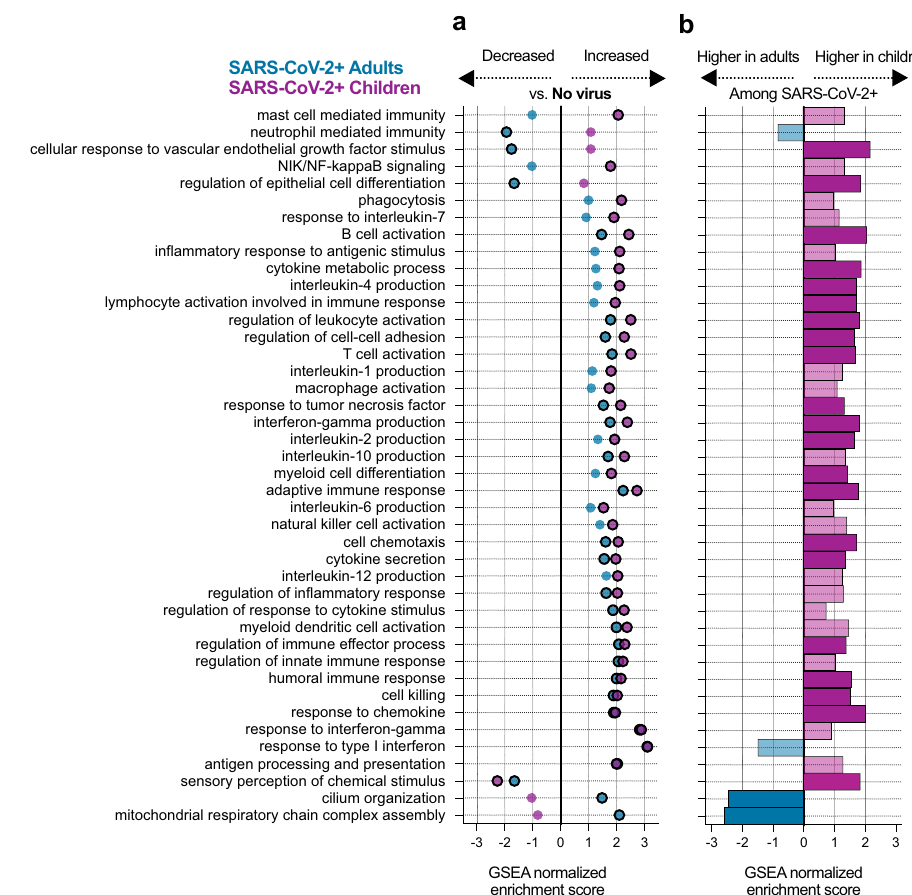
Fig. 2 Pathways activated in children and adults upon SARS-CoV-2 infection. a Normalized enrichment scores of selected GO biological process terms that reached statistical signi fi cance (adjusted p -value < 0.05) in the gene set enrichment analysis (GSEA) using differentially expressed (DE) genes between the SARS-CoV-2 and No Virus groups in either the adult or pediatric cohort. Color indicates the age cohort. Pathway p -values were calculated using an adaptive, multilevel splitting Monte Carlo approach and Benjamini – Hochberg adjusted, and statistical signi fi cance is denoted by a black outline around the circle. Complete results are provided in Supplementary Data 3. b Normalized enrichment scores for the same GO terms as in ( a ) in the GSEA using DE genes between children and adults with SARS-CoV-2 infection. Dark color bars represent pathways that reached statistical signi fi cance (adjusted p -value < 0.05). Complete results are provided in Supplementary Data